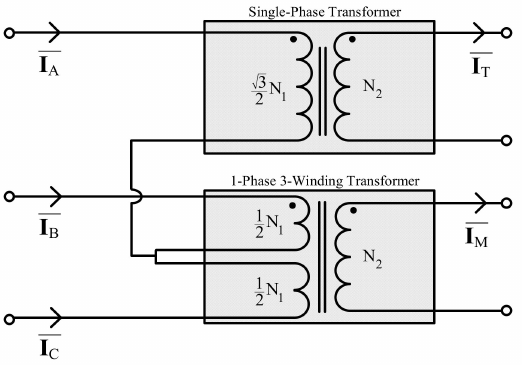
Figure 2. Scott connection using a single-phase transformer and a single-phase three-winding